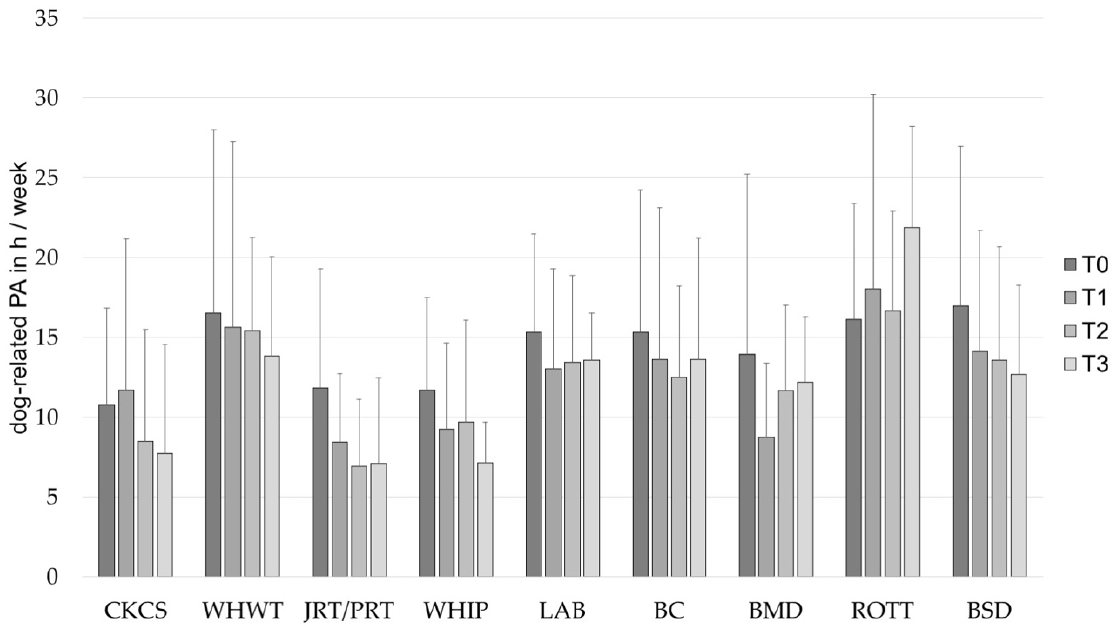
Figure 2. Dog-related PA in h/week (mean ± SD ) of owners of different dog breeds at baseline (T0), after 1 (T1), 2 (T2) and 3 (T3) years. BC, Border Collie; BERN, Bernese Mountain Dog; BSD, Belgian Shepherd Dog; CKCS, Cavalier King Charles Spaniel; JRT/PRT, Jack and Parson Russell Terrier; LAB, Labrador Retriever; PA, physical activity; ROTT, Rottweiler; WHIP, Whippet; WHWT, West Highland White Terrier.